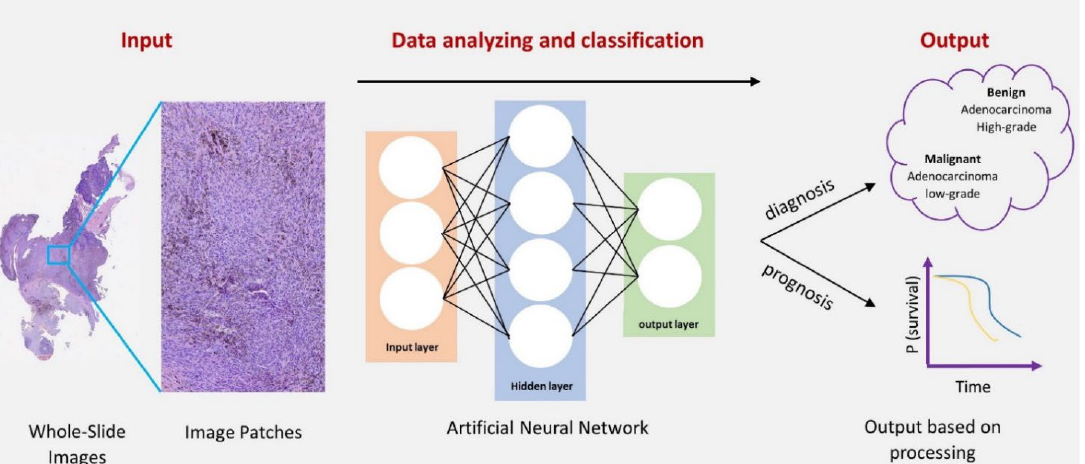
Figure 1. An overview of the deep learning process in pathology. Firstly, the whole-slide images (WSIs) were obtained from the original specimen slides. Then, the ongoing Artificial Neural Network (ANN) analysis process. Finally, the output of diagnosis or prognosis was based on the classification and selected